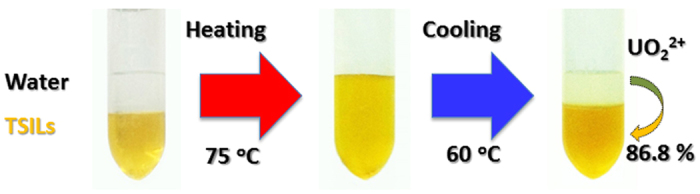
Fast homogeneous extraction of UO22+ by [HOOCmim][NTf2].